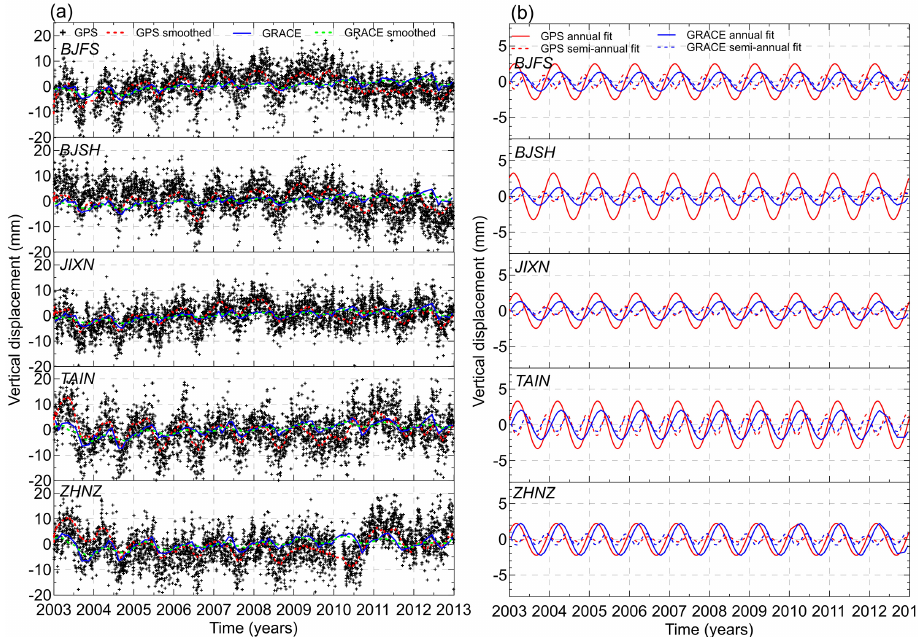
Figure 5. Time series showing daily values (a) and fitting results (b) of the vertical (positive upward) components from GPS and GRACE- derived at five IGS GPS